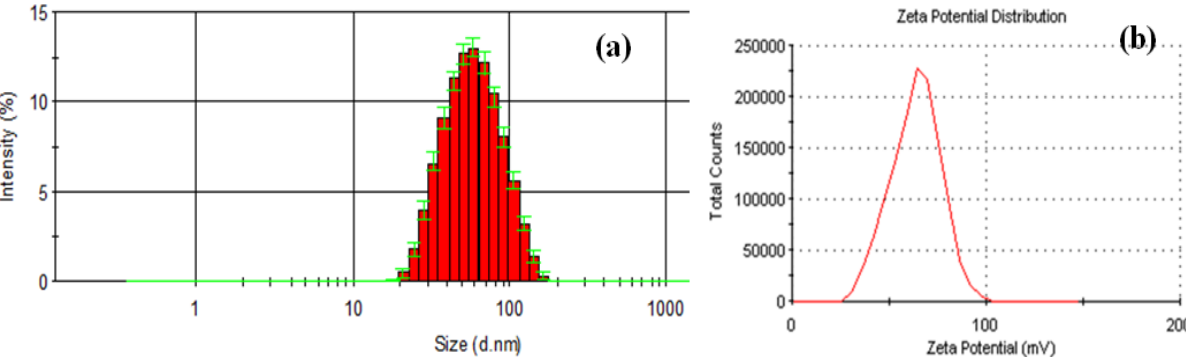
Figure 3. DLS histogram ( a ) and zeta potential distribution ( b ) of the Fe